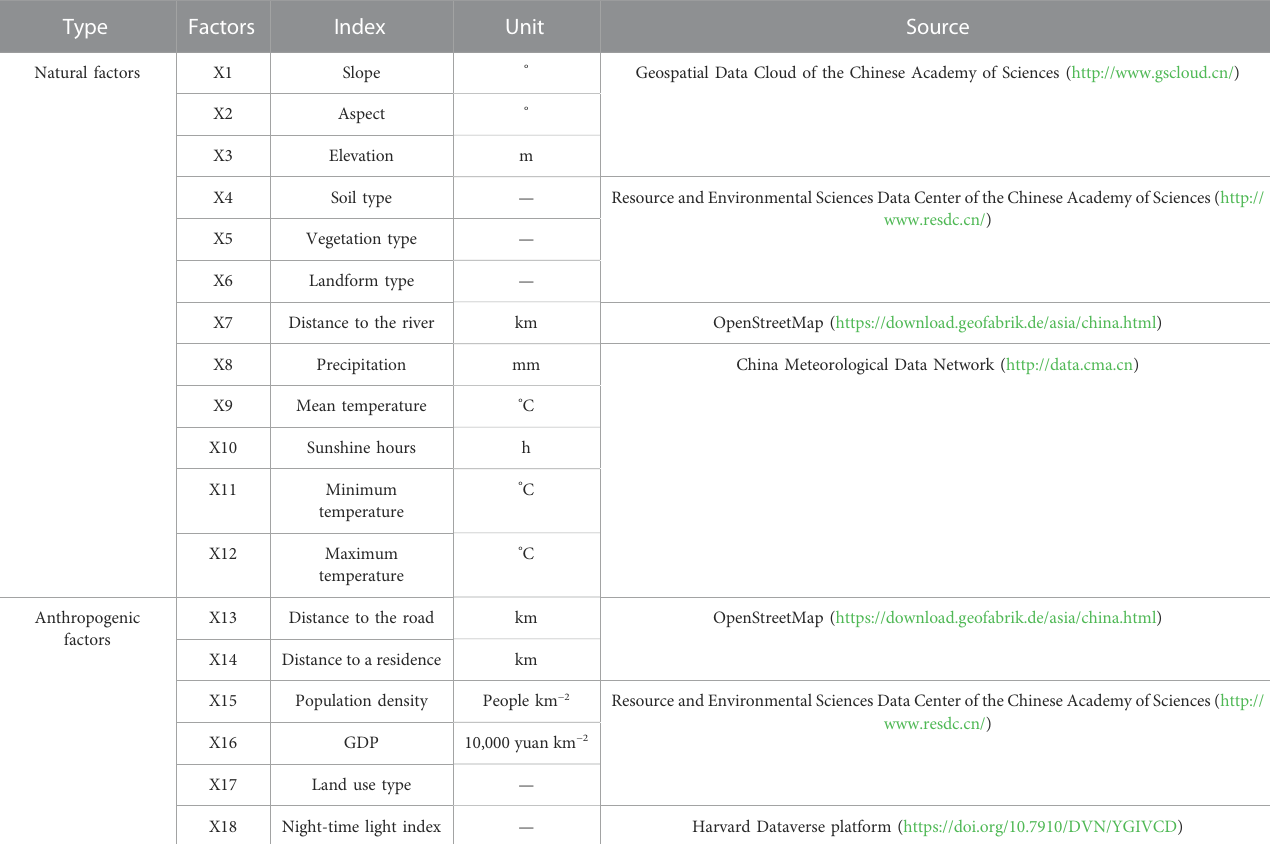
TABLE 1 Detection factors.